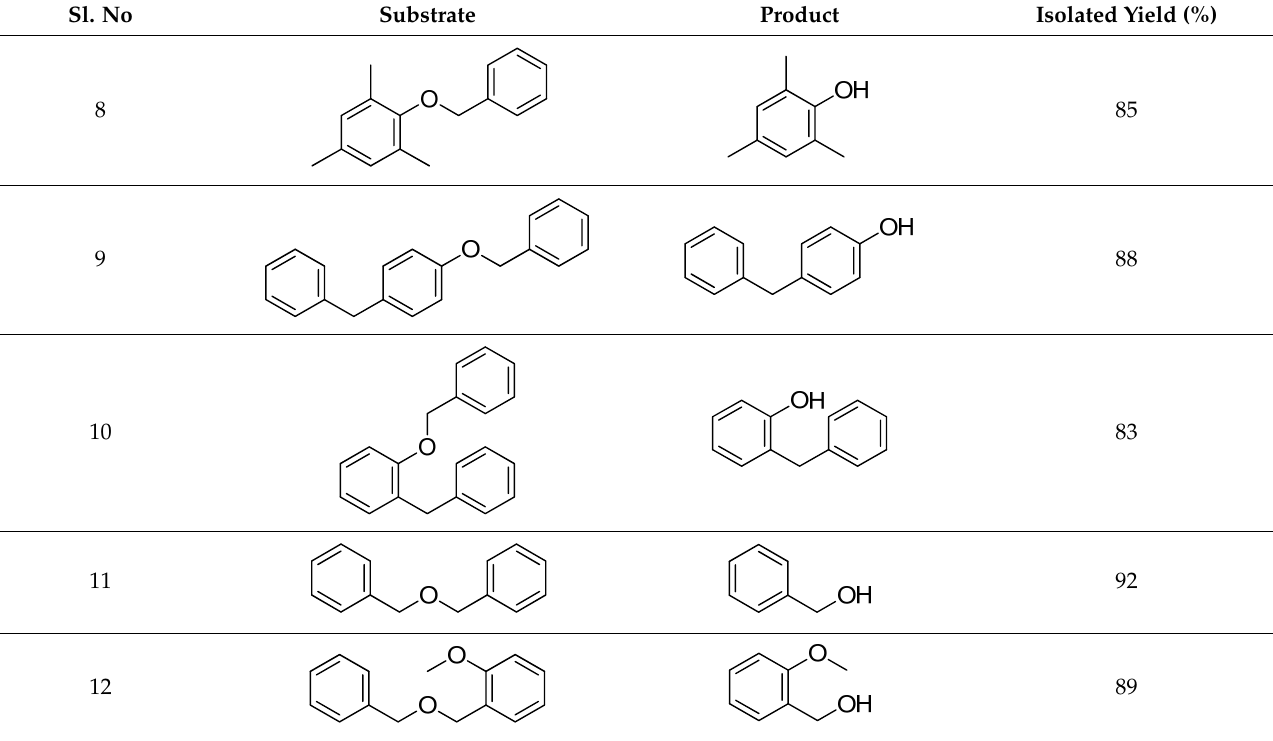
Table 3. Comparison of catalytic activity of Ru ‐ GCN Nanocomposite with other reported catalysts for the Hydrodeben ‐ zylation reaction. Entry.